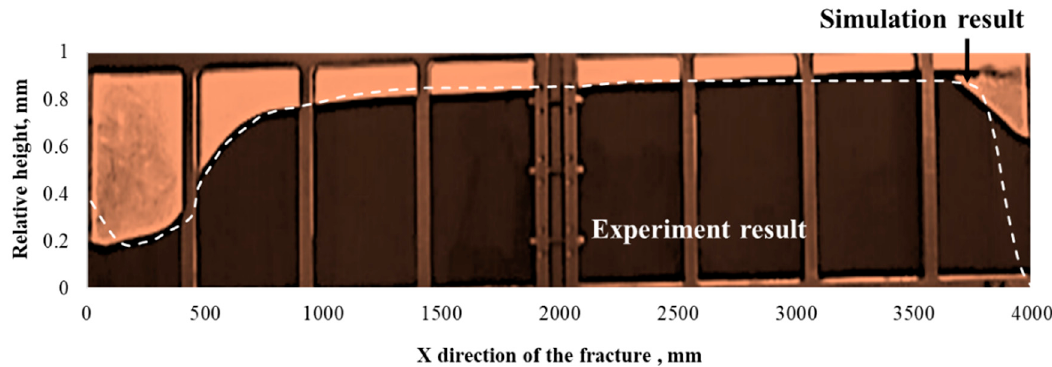
Figure 6. Comparison of proppant placement pattern obtained from experiment and simulation at the final equilibrium state.